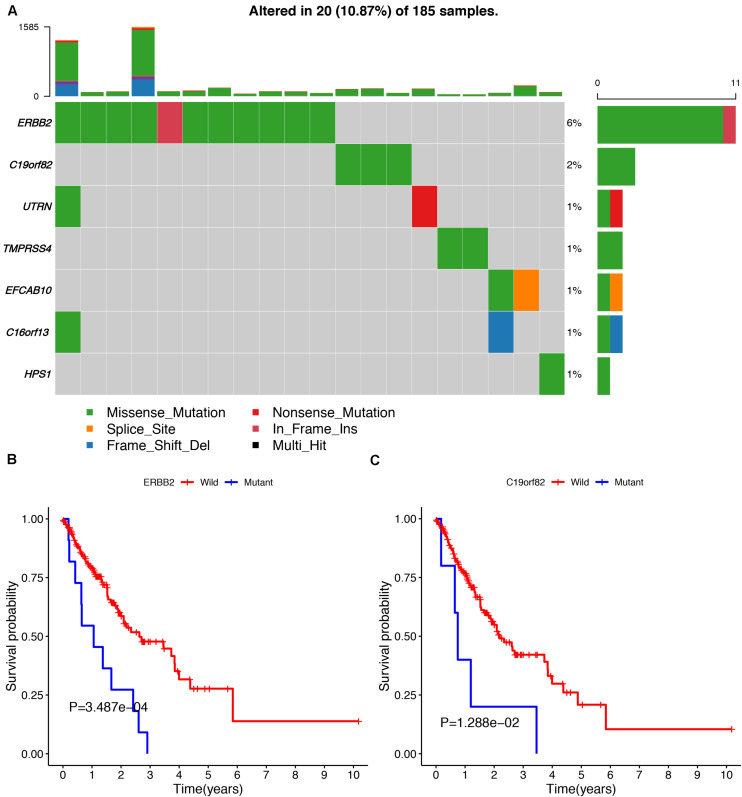
The mutation profiling of parent genes in ESCA samples. (A) The waterfall plot of parent genes in ESCA cohort. (B,C) Kaplan-Meier survival curves of two different mutated genes (ERBB2 and C19orf82).